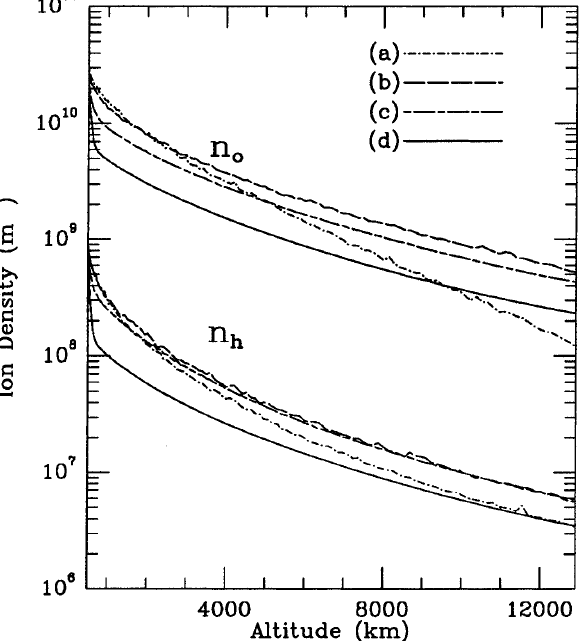
Fig. 15. Profiles of the O (cid:135) and H (cid:135) densities. The labels correspond to the cases listed in Table 3